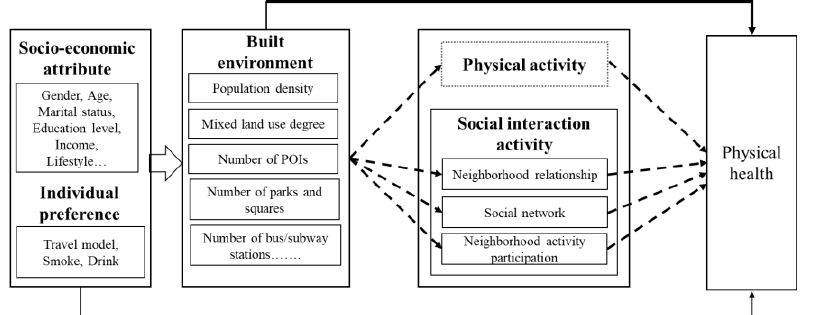
Figure 1. Research